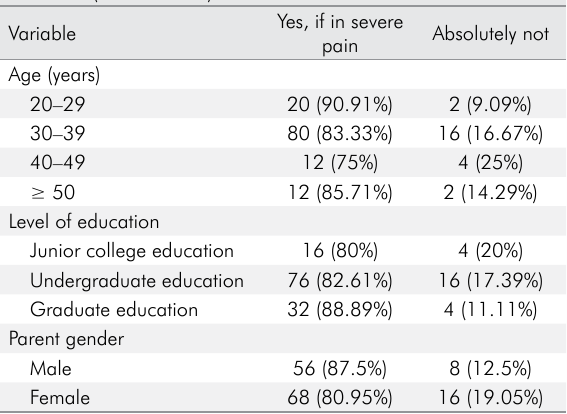
Table 6. Data on parents’ confidence in the dental department after learning that the department had taken protective measures (by parent age, level of education and